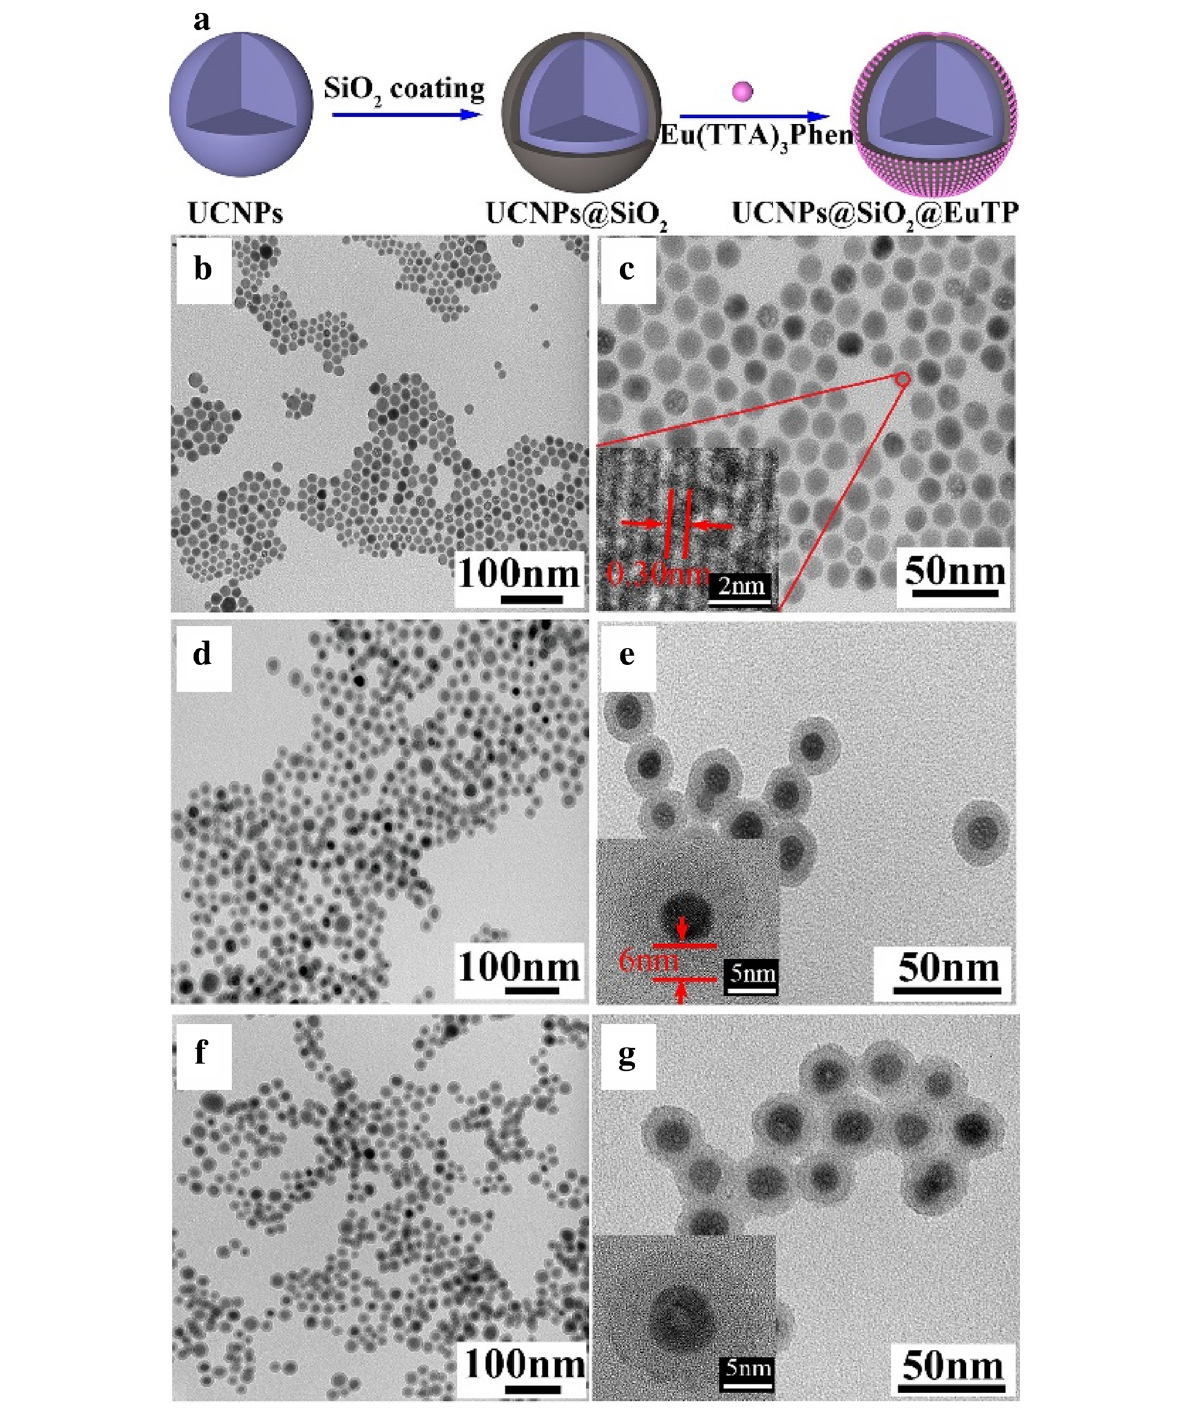
Fig. 5 a The formation of UCNPs@SiO 2 @EuTP and TEM (transmission electron microscope) images of the samples; b , c for UCNPs, d , e for